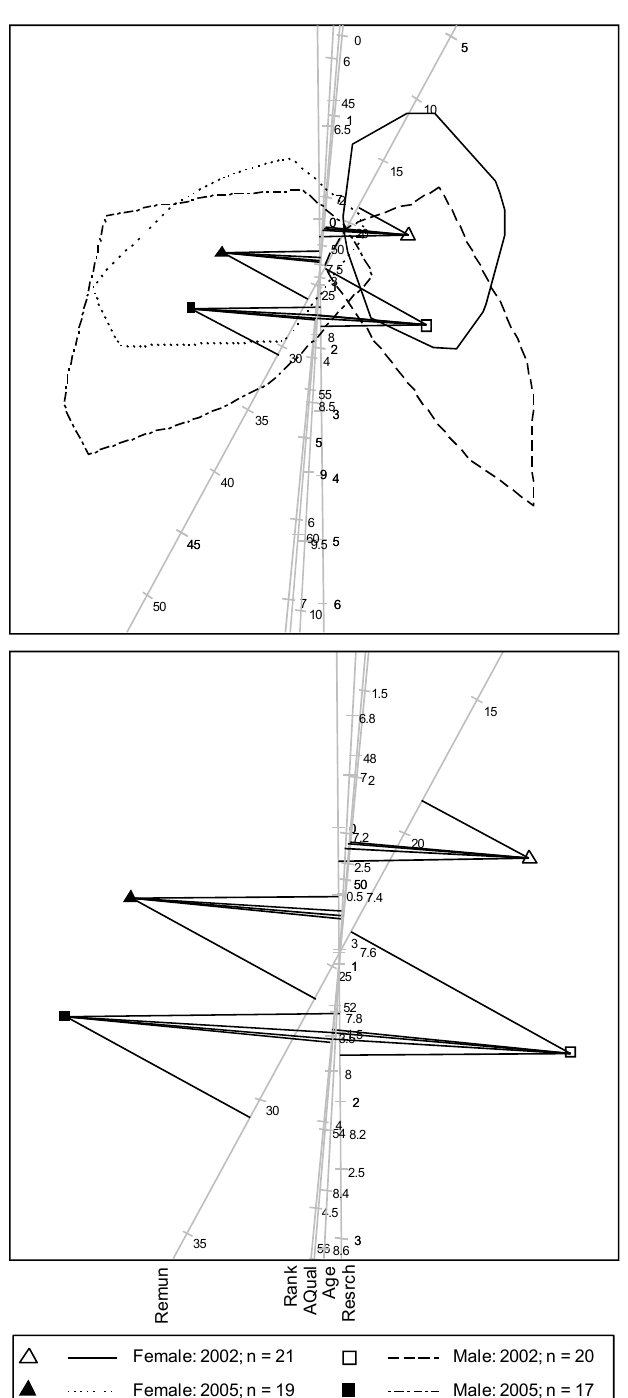
Figure 9: CVA biplot separating C1 staff in the Faculty of Education according to the 2002 Female, 2005 Female, 2002 Male and 2005 Male subgroups. Plotting of data points is suppressed. The upper panel shows the biplot overlaid with 90% bags. The bottom panel shows the group means on a large scale together with perpendicular lines from each group mean to the five axes for determining the biplot predictions of the different